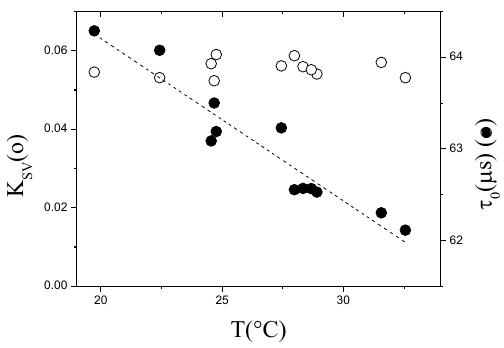
Figure 9. Calibration of τ 0 ( T ) and K SV ( T ) with T . PtFTPP-PSF membrane supported on Mylar ® made in 12%